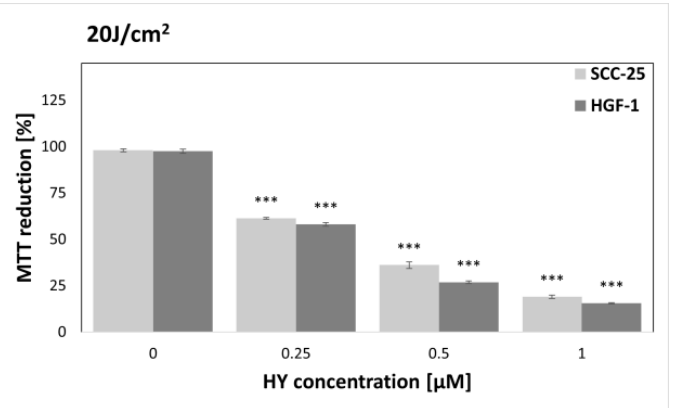
Figure 8. MTT reduction in the SCC-25 and HGF-1 lines for different HY concentrations: 0 µM, 0.25 µM, 0.5 µM, and 1 µM and light dose 20 J/cm 2 . The values represent the means ± SE. *** p < 0.01.